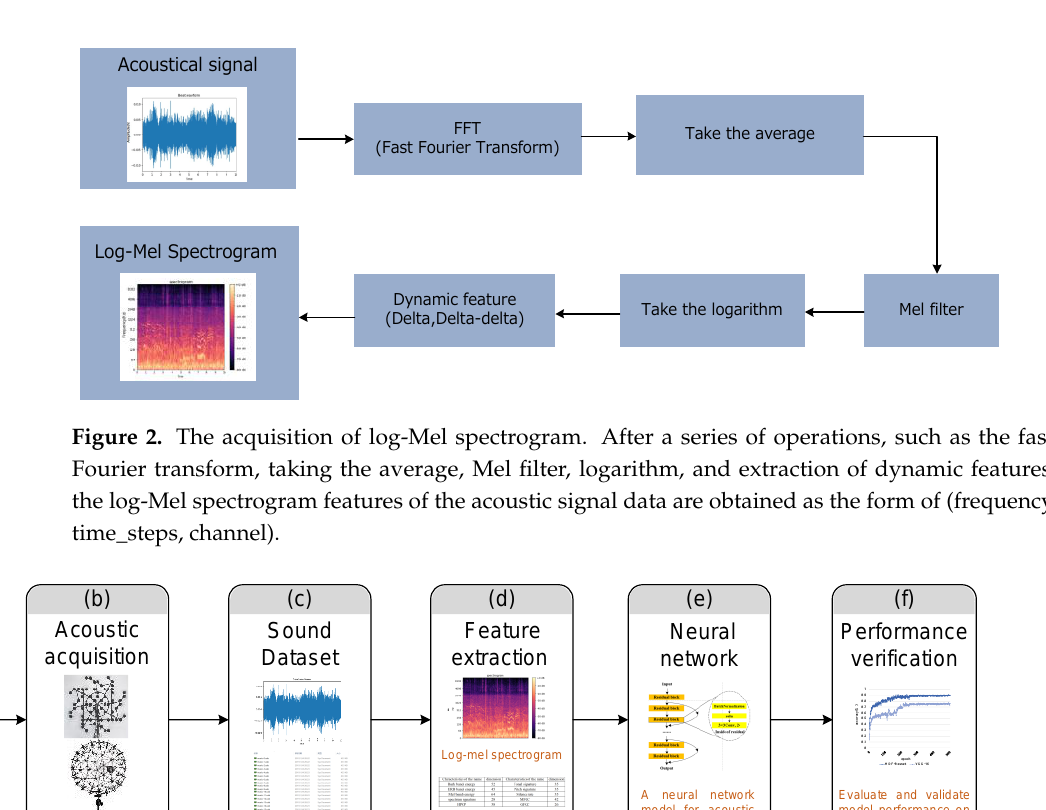
Figure 2. The acquisition of log-Mel spectrogram. After a series of operations, such as the fast Fou- rier transform, taking the average, Mel filter, logarithm, and extraction of dynamic features, the log- Mel spectrogram features of the acoustic signal data are obtained as the form of (frequency, time_steps, channel).